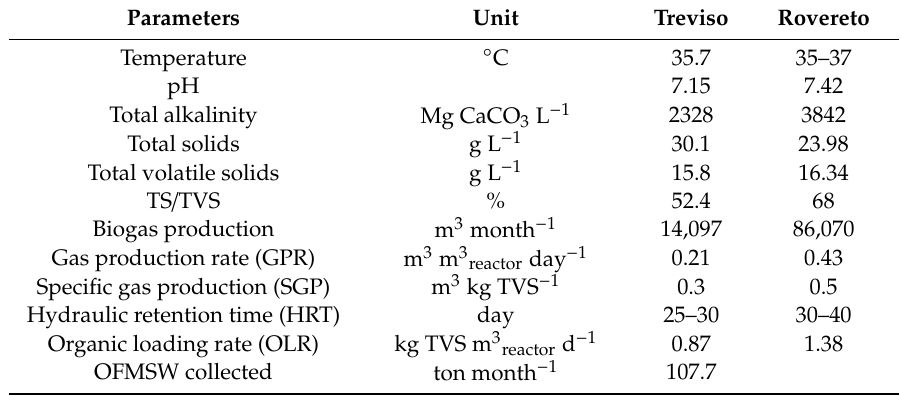
Table 2. Treviso (seven years) and Rovereto (one year, [24]) anaerobic digestion process performance monitoring. TS: total solids; TVS: total volatile